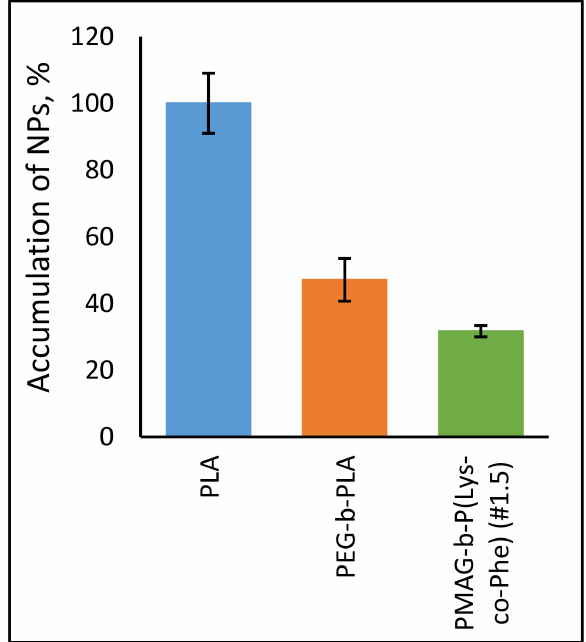
Figure 11. Uptake of the Cy 5 -labeled NPs by J774 A.1 macrophages. ( C NPs = 50 µ g/mL, C Cy5 = 3 µ g/mg of NPs, t = 6